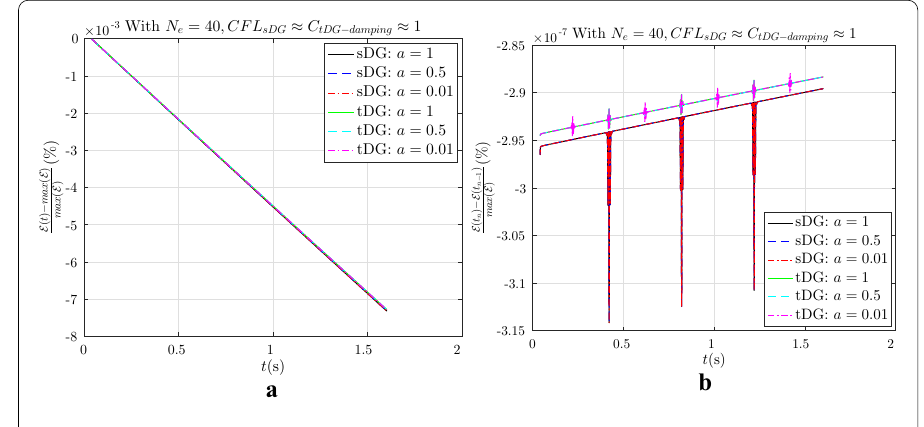
Fig. 2 Decreasing of the total energy over time by both space and time dG methods with different degrees of discontinuity. a Total loss accumulated w.r.t. time; b incremental loss w.r.t.